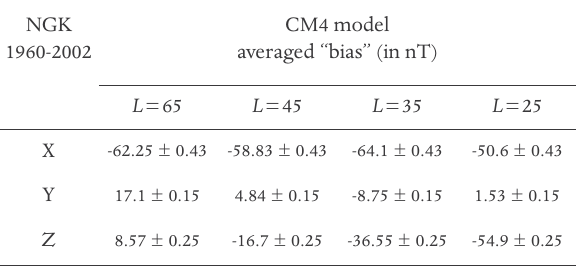
Table 2. Averaged “bias” of CM4 model at NGK observatory (1960- 2002 period).